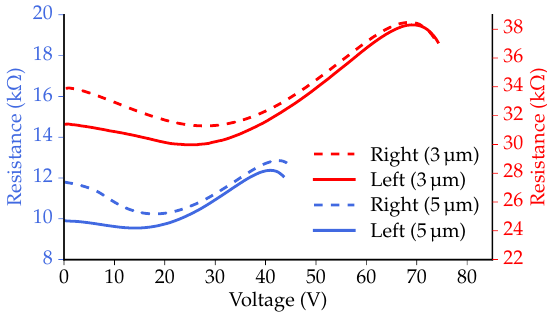
Figure 9. The results of current sweep measurements, showing the measured resistance of the actuators as a function of the measured voltage over the